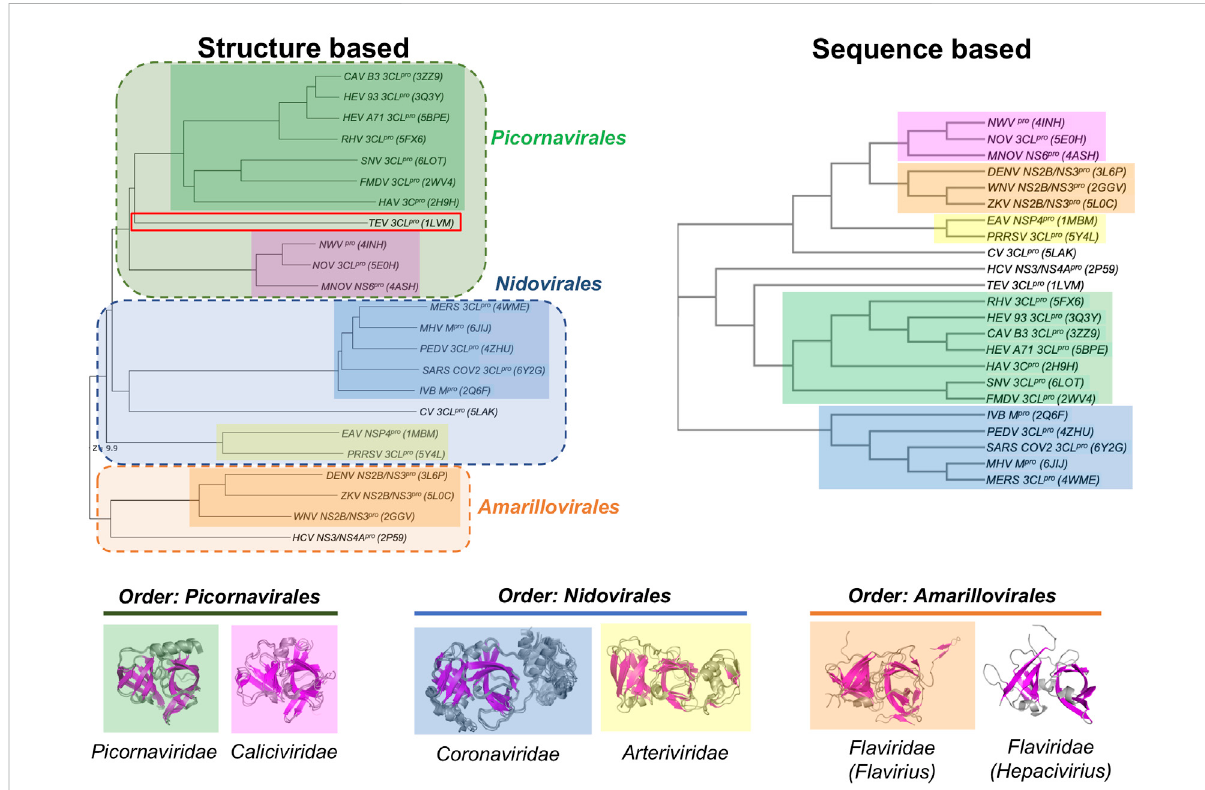
FIGURE 4 Dendrograms showing the structure-based vs. sequence-based relationships of viral proteases. In both the structure-based and sequence- based dendrograms, proteases belonging to the members within the same viral Family cluster together in clades, represented by different colored boxes. Superimpositions of the corresponding structures in each Family clade is shown below the